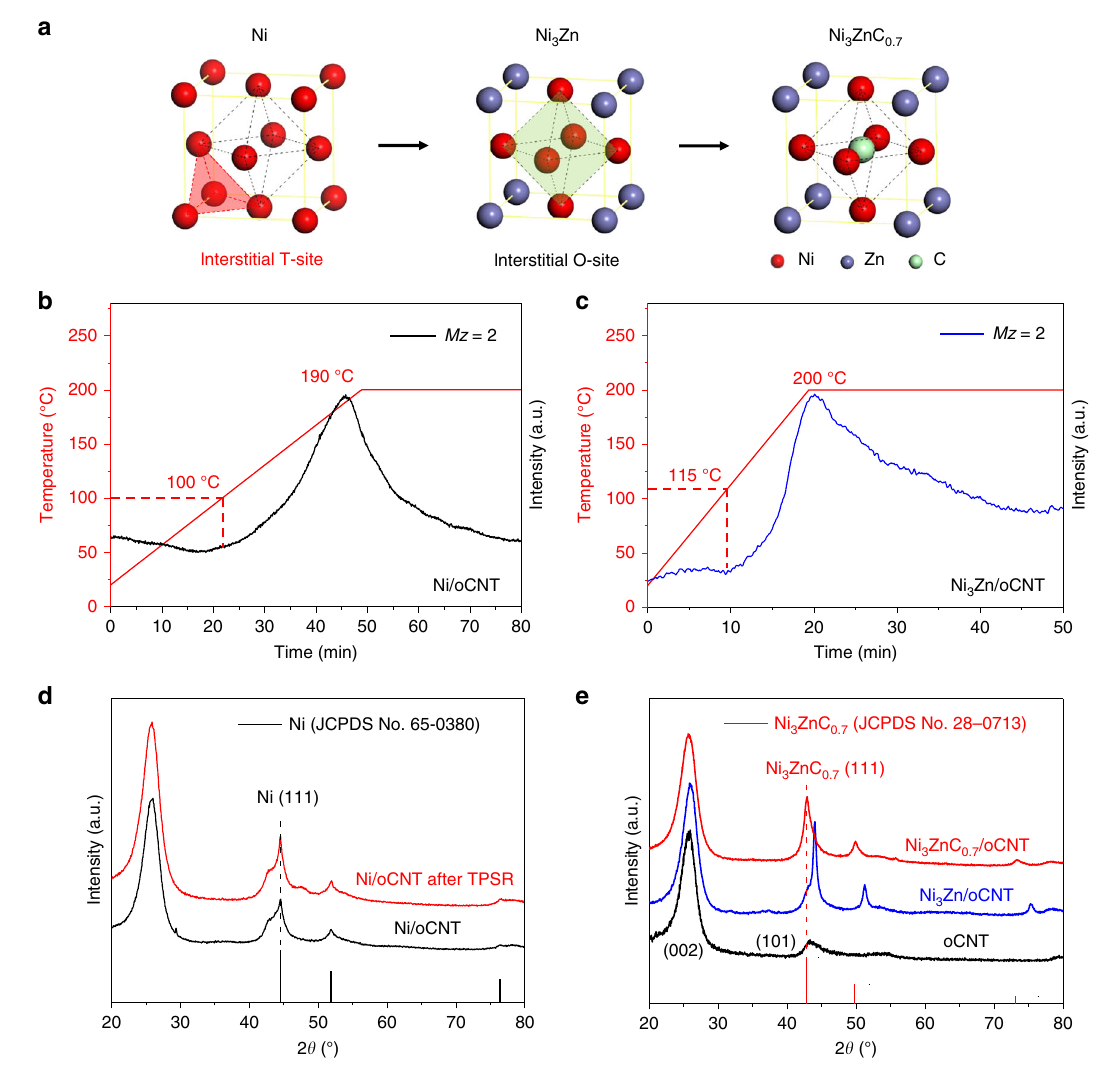
Fig. 1 Incorporation of carbon atom in Ni 3 Zn. a Schematic of expanded interstitial sites in the unit cells of Ni, Ni 3 Zn, and Ni 3 ZnC 0.7 . The red and black dash lines indicate the tetragonal and octahedral interstitial sites. TPSR-MS results of Ni/oCNT ( b ) and Ni 3 Zn/oCNT ( c ) at elevated temperatures under 1.0 vol % C 2 H 2 /He atmosphere. XRD patterns of Ni/oCNT ( d ) and Ni 3 Zn/oCNT ( e ) after reduction and acetylene